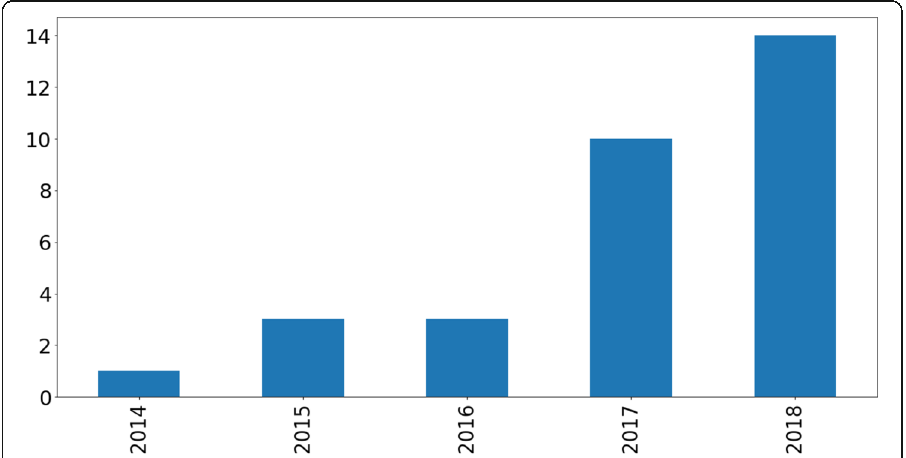
Fig. 3 The number of research publications dedicated to VR games per